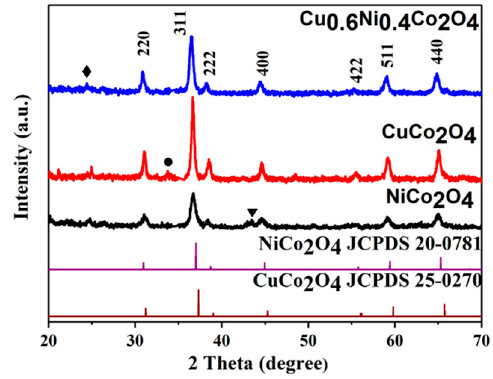
Figure 1. X-ray diffraction (XRD) pattern of the NiCo 2 O 4 , CuCo 2 O 4 , and Cu 0.6 Ni 0.4 Co 2 O 4 powders.